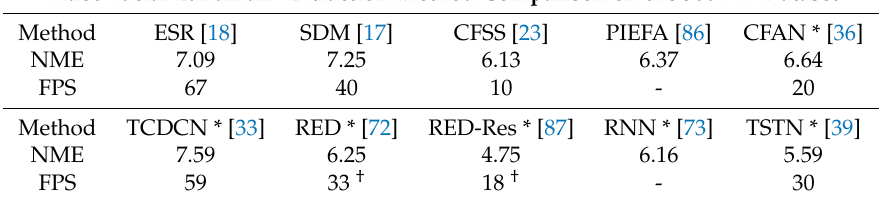
Table 2. Comparison of the Mean Error (%) (normalized by face size) of different video facial landmark extraction methods on 300VW. The data was obtained from [72] and original publications. * indicates deep-learning-based methods. † indicates that the runtime is measured on GPU (graphics processing